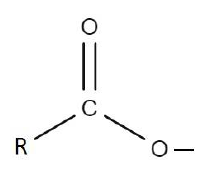
Figure 8. A carboxylate of a carboxlic acid.